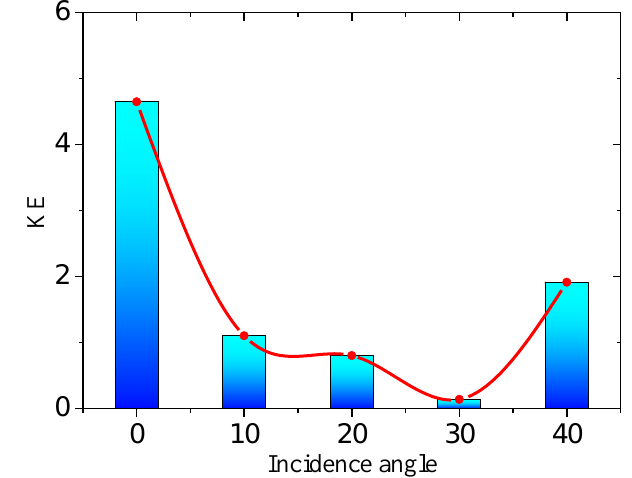
ff erent incidence